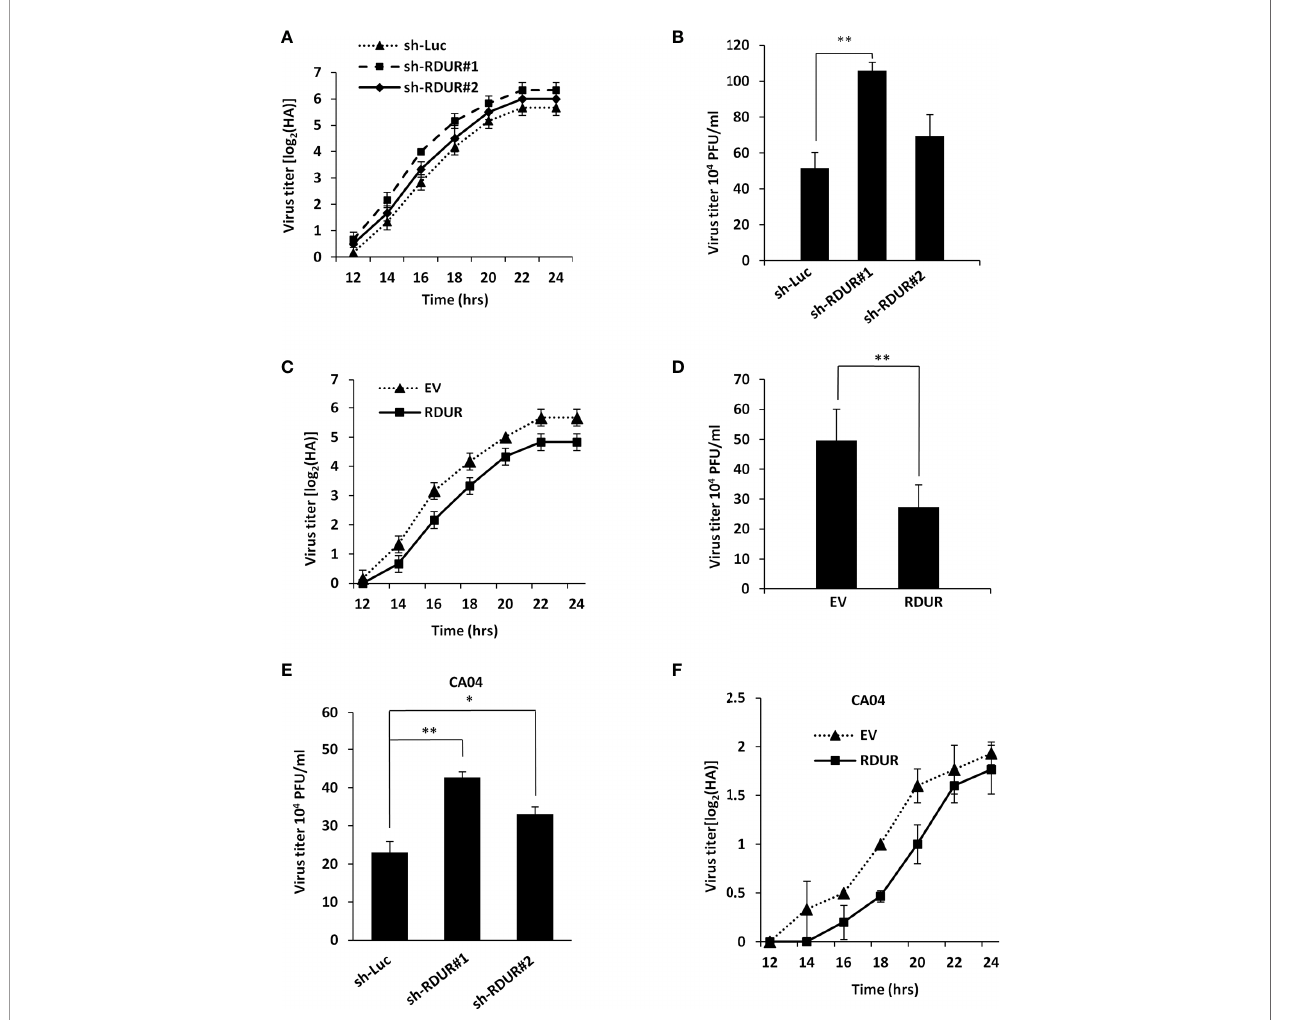
FIGURE 2 | Altering RDUR expression impacts IAV replication in A549 cells. (A) RDUR knockdown A549 cell lines were infected with WSN and the virus titers in the supernatants were measured by hemagglutinin (HA) assay at indicated time points. Luciferase shRNA (sh-Luc) served as a control. Shown are average results from three independent experiments. Data are shown as means ± SD. (B) RDUR knockdown A549 cells were infected with WSN for 16 h and the virus titers were measured by plaque assay. Plotted are the average levels from three independent experiments. Data are shown as means ± SD, ** P < 0.01. (C) A549 cells overexpressing RDUR were infected by WSN and the virus titers at indicated time points were measured as described in (A) . Data are shown as means ± SD. (D) A549 cells overexpressing RDUR were infected by WSN for 16 h and the virus titers were measured by plaque assay. Cells expressing empty vector (EV) were used as control. Plotted are the average results from three independent experiments. Data are shown as means ± SD, ** P < 0.01. (E) RDUR knockdown A549 cells were infected by CA04 virus for 16 h and the titers were measured by plaque assay. Plotted are the average levels from three independent experiments. Data are shown as means ± SD. * P < 0.05, ** P < 0.01. (F) RDUR overexpressed A549 cells were infected by CA04 virus and the virus titers were measured by HA assay at indicated time points. Data are shown as means ±